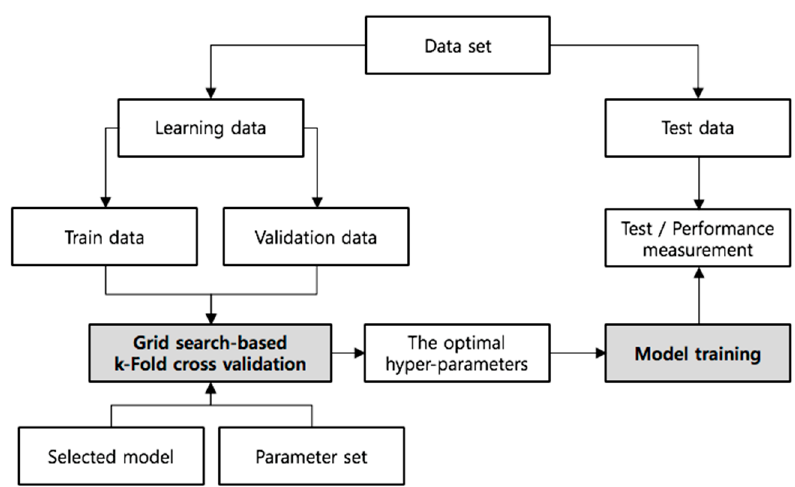
Figure 5. Process of hyper-parameter selection and model evaluation with the cross-validated grid-search. Multi-Layer LSTM and CNN + LSTM Model Tuning